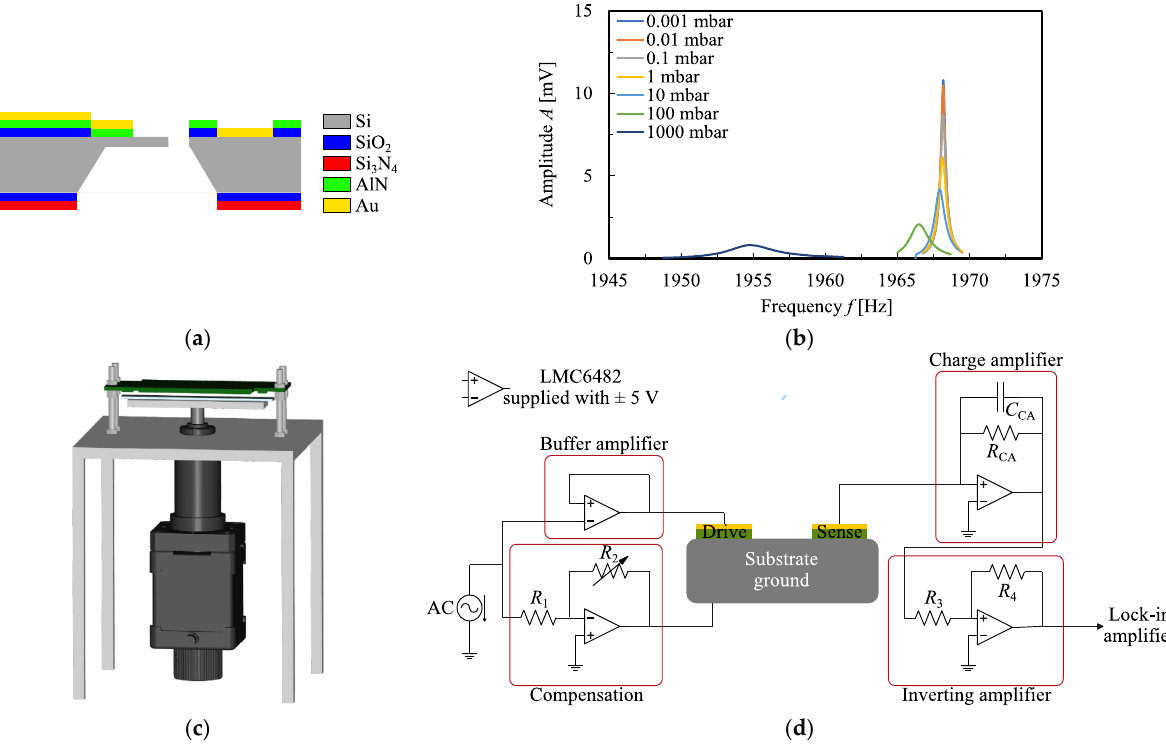
Figure A2. Cross-sectional view on a micro-oscillator (layer thickness are not to scale) ( a ), and recorded resonance curves of BO1 ( b ) for various ambient pressure levels. In ( c ), the construction for adjusting the gap width to the neighboring plate is depicted, and in ( d ) the electric circuit for the actuation and detection of the micro-oscillators.